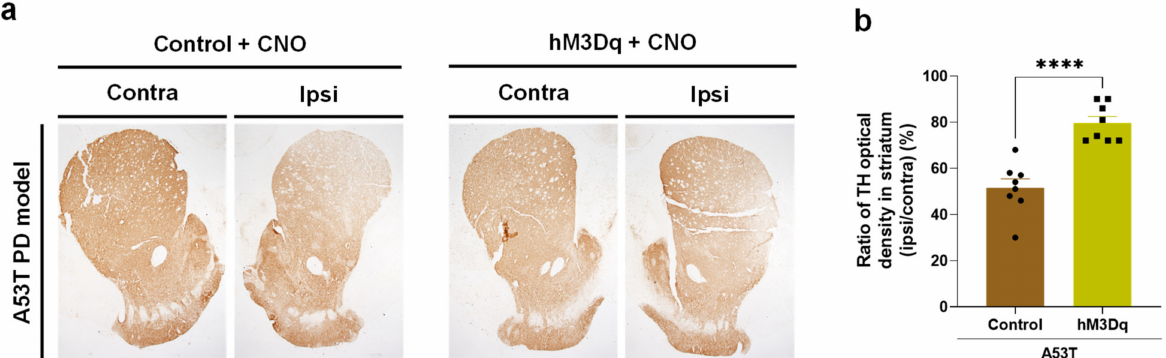
Figure 7. Chemogenetic activation of DDC + neurons alleviates the striatal TH loss in the A53T rat PD model. ( a ) Representative images of striatum, which was immunolabeled with anti-TH antibody; ( b ) the optical density of TH in the ipsilateral striatum compared to the contralateral side (Control, n = 8 rats; hM3Dq, n = 8 rats). The data are presented as the mean ± SEM. The data normality was assessed by Shapiro–Wilk normality test. Since the data was not normally distributed, statistical significance was calculated by the Mann–Whitney test. The significance level is represented as asterisks (**** p <